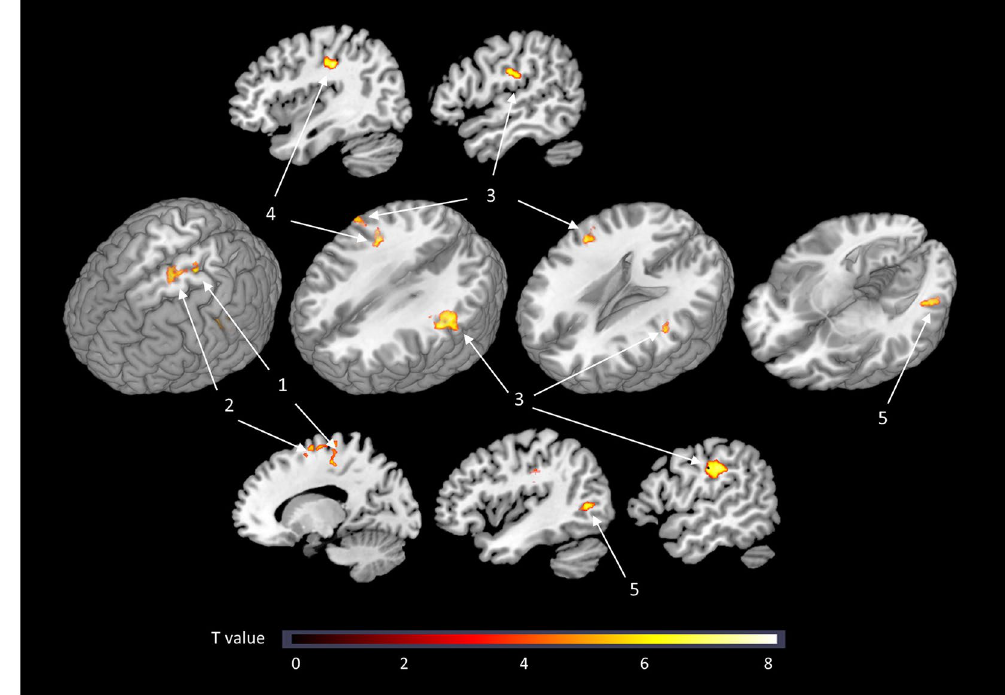
Figure 4. Brain areas showing a decreased BOLD response to SS after CBT-I in a voxel-wise whole-brain comparison. 1: Left precentral cortex. 2: Left supplementary motor cortex. 3: Bilateral supramarginal cortex. 4: Right postcentral cortex. 5: Left middle temporal cortex. Note: BOLD response to SS was calculated by subtraction of the BOLD response to NS from that to SS (SS -